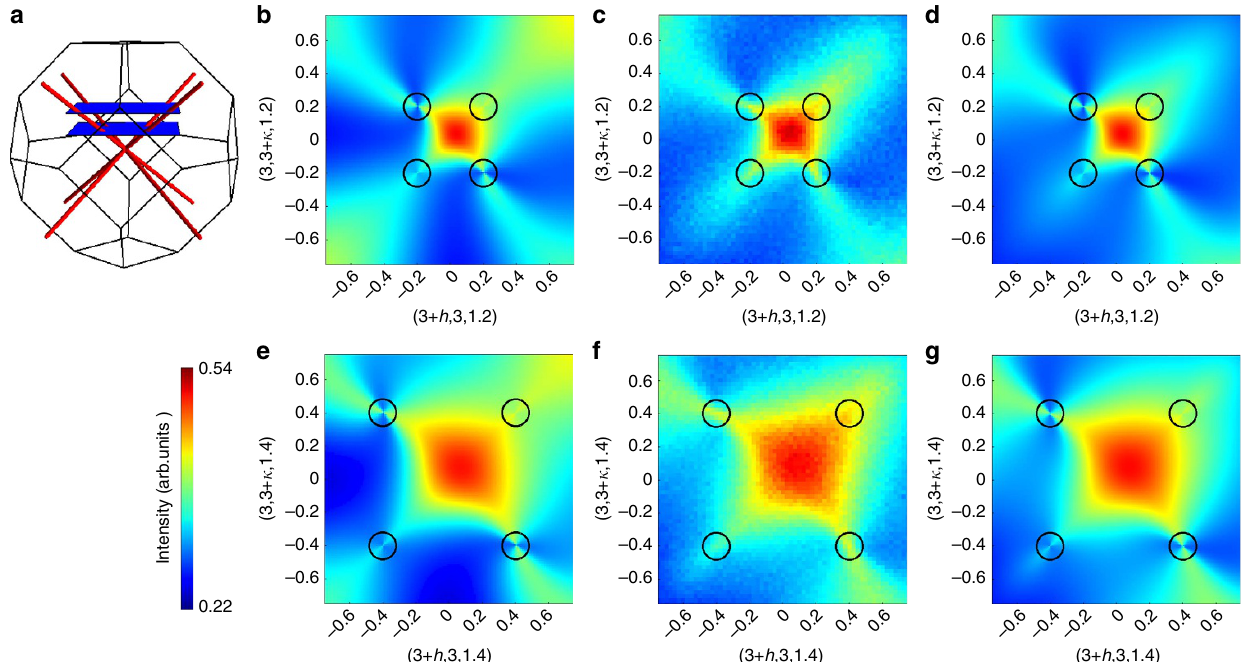
Figure 3 | Gauge structure of the spin-liquid as revealed through pinch-line singularities. ( a ) Location of pinch-line singularities in reciprocal space. ( b , e ) Spin structure factor S ( q ) in parallel planes in reciprocal space in the Brillouin zone centred on K ¼ (3,3,1), as calculated from the continuum theory (equation (11)). Singular features are visible where these planes intersect h 111 i directions, as indicated by the black circles in each panel. These pinch-line singularities, equation (12), are characteristic of the gauge structure of the spin-liquid. ( c , f ) Spin structure factor calculated in finite temperature Monte Carlo simulation, in the same regions of reciprocal space. The pinch lines appear in the simulation results as sharp features around the point where h 111 i directions intersect the plane. ( d , g ) A calculation of the structure factor made with a lattice-based 1 = N theory, also exhibiting pinch-line singularities. The simulations were performed at a temperature T ¼ 0.001K for a cluster of N ¼ 256,000 sites and dimensions 40 a 0 (cid:5) 40 a 0 (cid:5) 10 a 0 where a 0 is the linear size of a cubic unit cell. Results were calculated for parameters J 1 ¼ 0.042, J 2 ¼ 0.122, J 3 ¼ (cid:3) 0.118 and J 4 ¼ (cid:3) 0.04meV, with anisotropic g -tensor g ? = g k ¼ 1 = 3, in approximate correspondence to Tb 2 Ti 2 O 7 (ref. 55). Since the crystal field ground state in Tb 2 Ti 2 O 7 is a non-Kramers doublet,